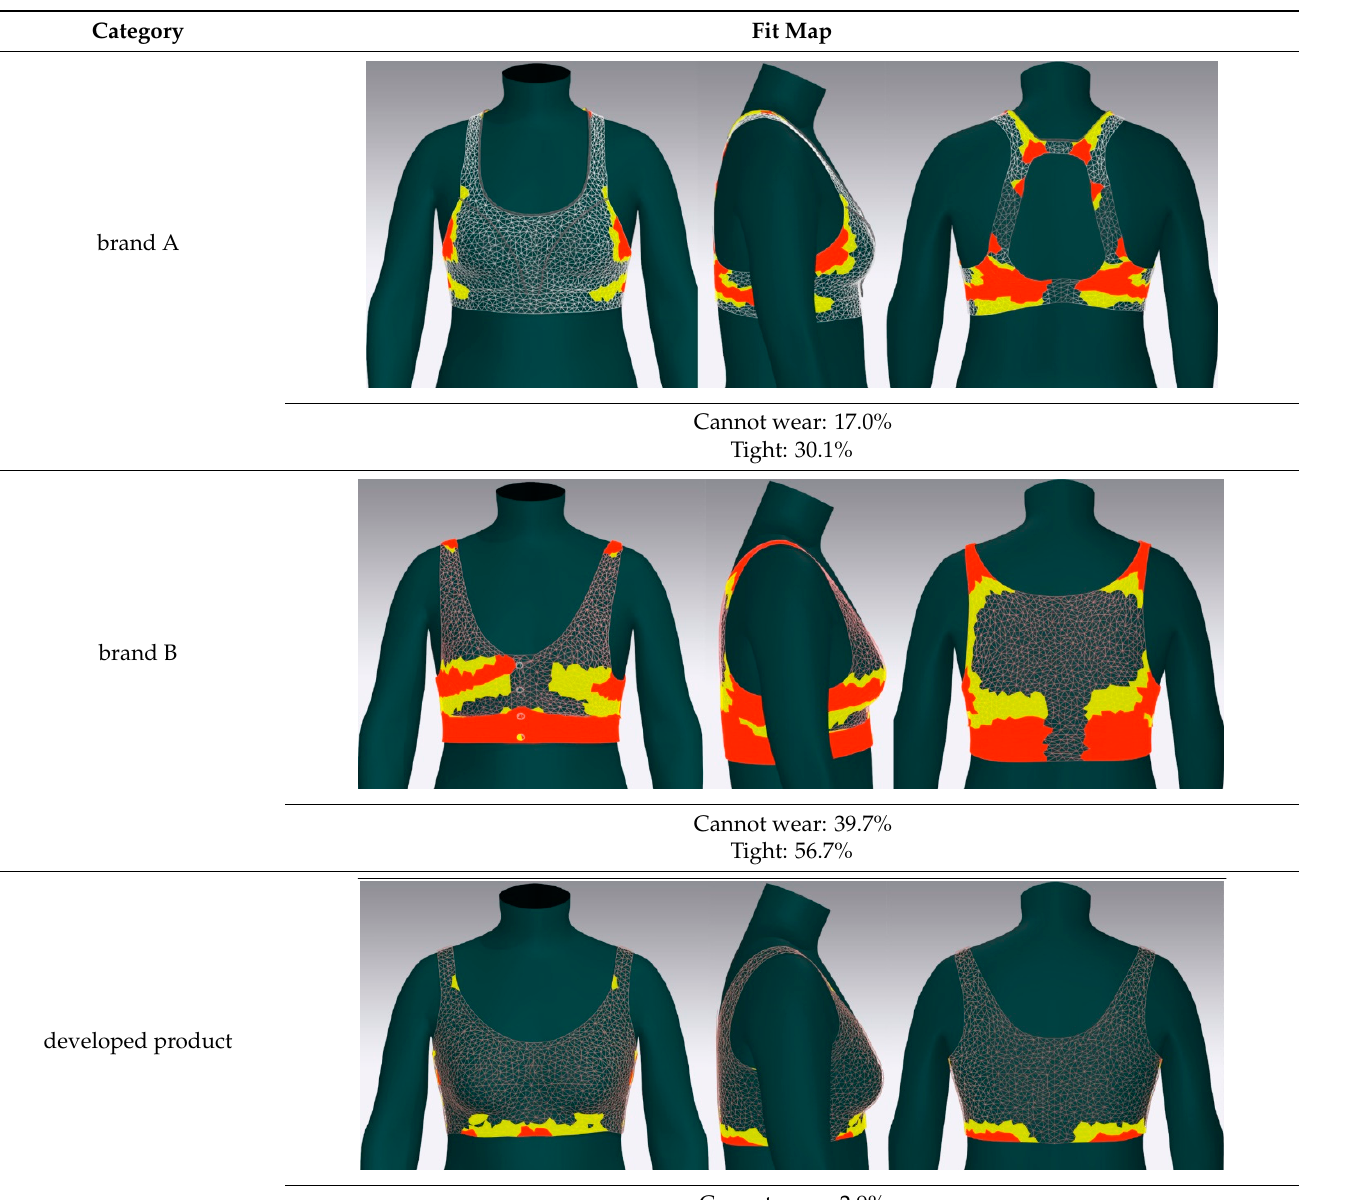
Table 6. Results of virtual fitting by Fit Map.